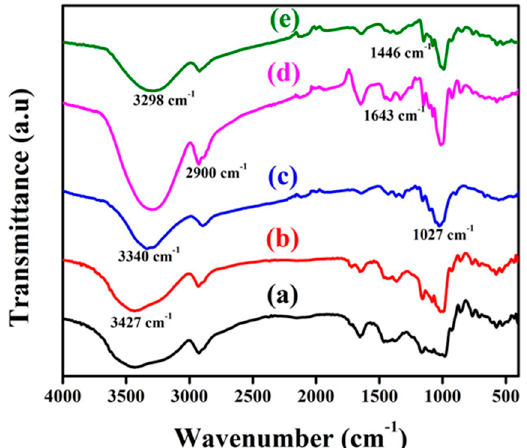
Figure 1. FTIR images of PS ( a ), TS ( b ), GNF ( c ), and 5% GNF with PS ( d ) and TS ( e ) composites.